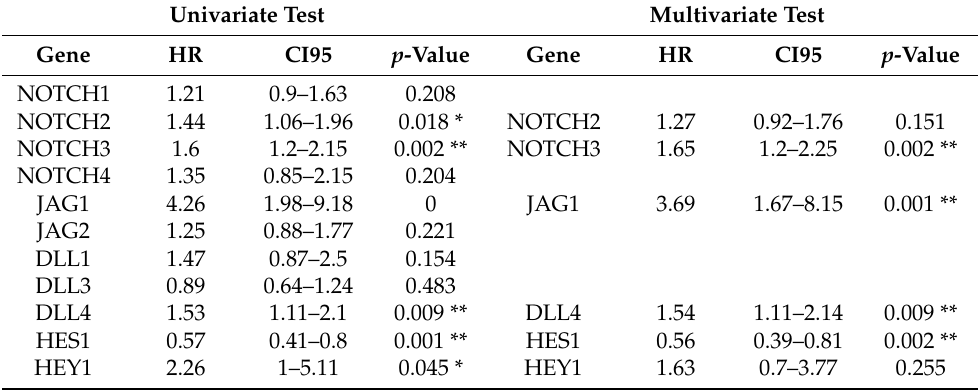
Table 4. Risk assessment of Notch components on